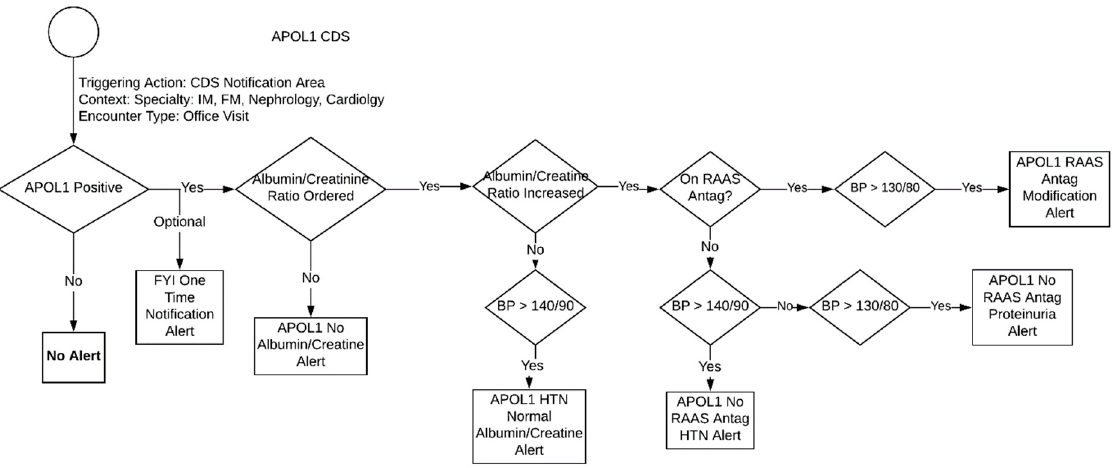
Figure 1. Proposed APOL1 genotype guided therapeutic algorithm.